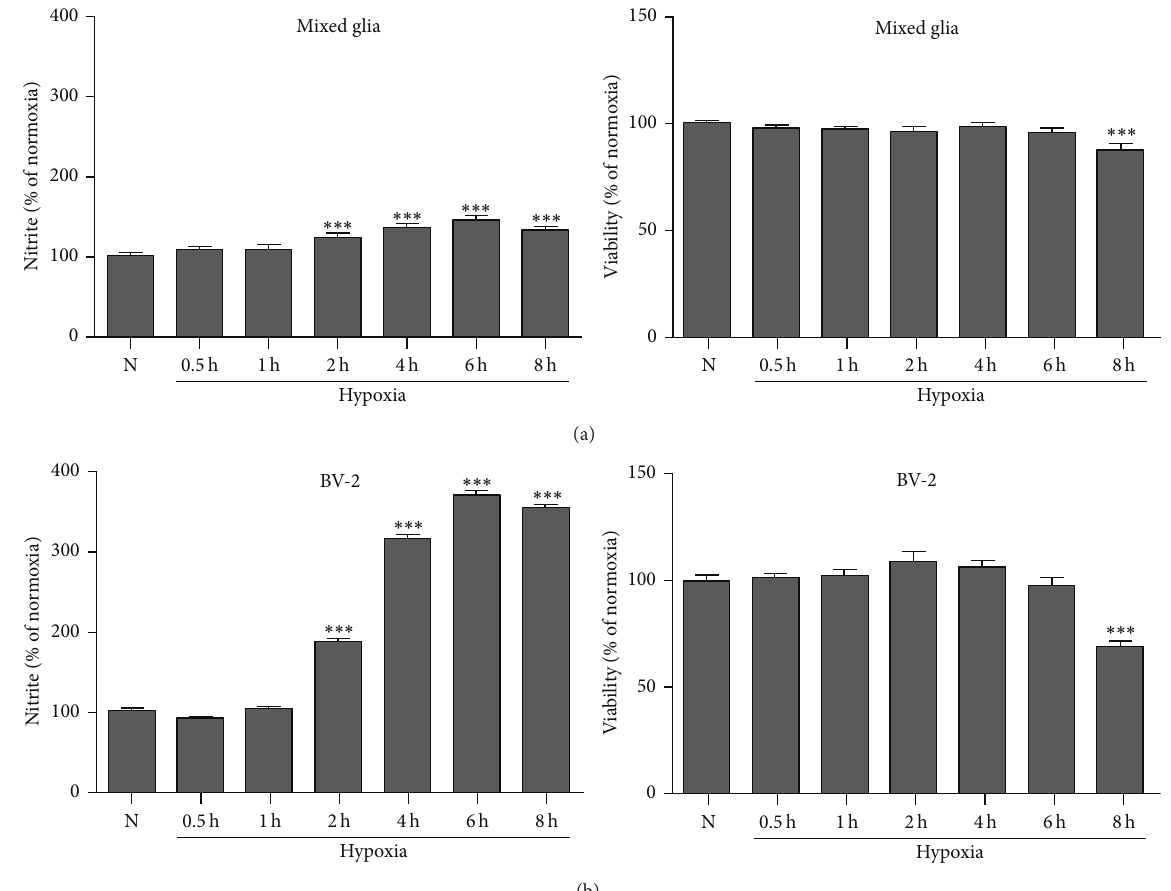
Figure 4: Hypoxia insult induces glial activation in cultured glial cells without reducing cell viability. Nitrite production and cell viability were determined in a primary mixed glial culture (a) and in the BV-2 microglial cell line (b) after exposure to hypoxia, at various time intervals (as indicated). Hypoxia durations up to 6h increased nitrite production in a time-dependent manner without reducing cell viability. Hypoxia exposure for 8h was able to induce a low level of cell death. The data represent the mean ± standard error of the mean (SEM), based on five independent experiments in each group. ((a), (b)) ∗∗∗ 𝑃 < 0.001 compared with HI